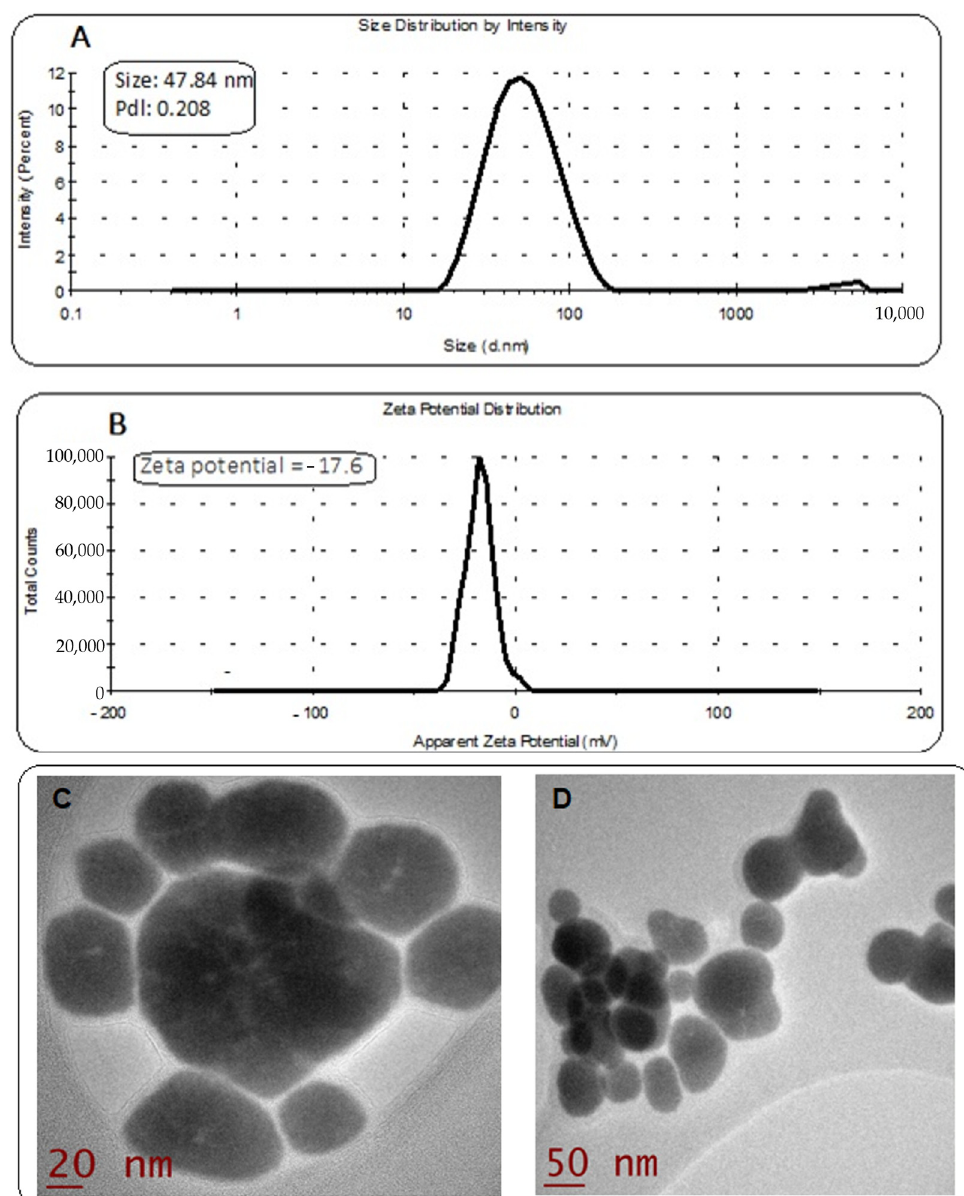
Figure 3. DLS analysis of synthesized GA/LU/DIO-SeNPs; size: 43–121 nm; average size: 70.9 nm ( A ) and zeta potential measurement ( B ); transmission electron microscope (TEM) images of LU/DIO-SeNPs in the presence of GA aqueous solutions ( C , D ).